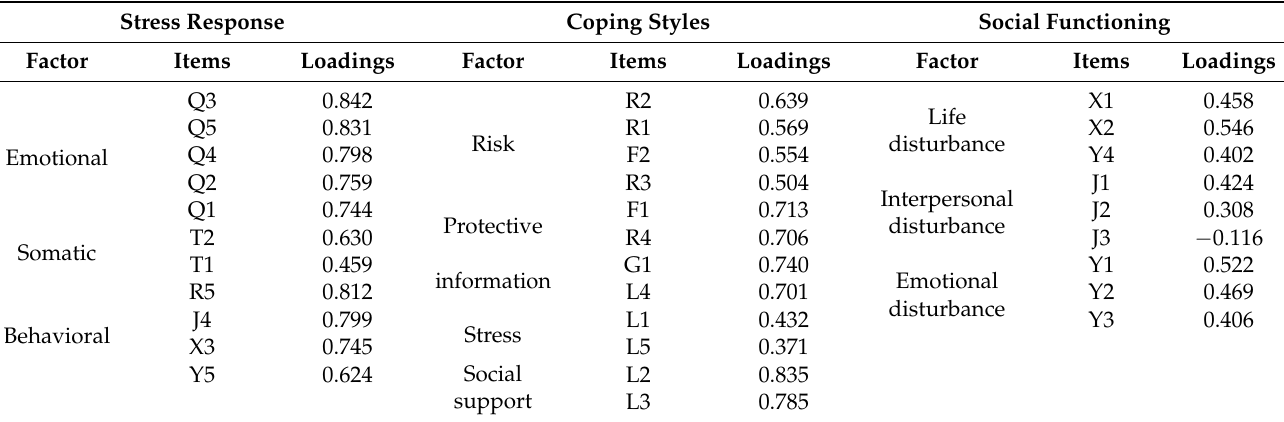
Table 1. Factor loadings for each entry ( n =